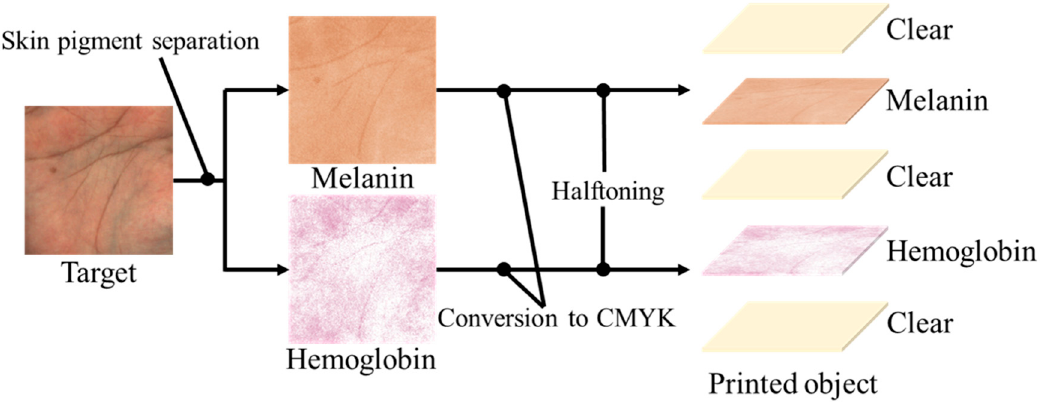
Figure 3. Our workflow for human skin reproduction with multilayer spatial distribution of pig- ment components.